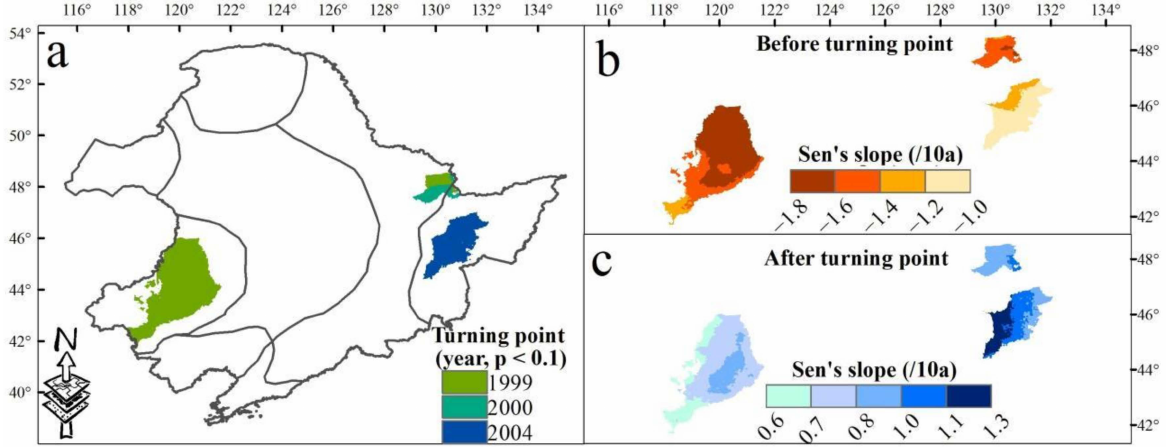
Figure 7. Mutation point ( p < 0.1, ( a )) of the spatial variation trend of SPEI12 and the change slope before ( b ) and after ( c ) the mutation point in northeast China (NEC) from 1990 to